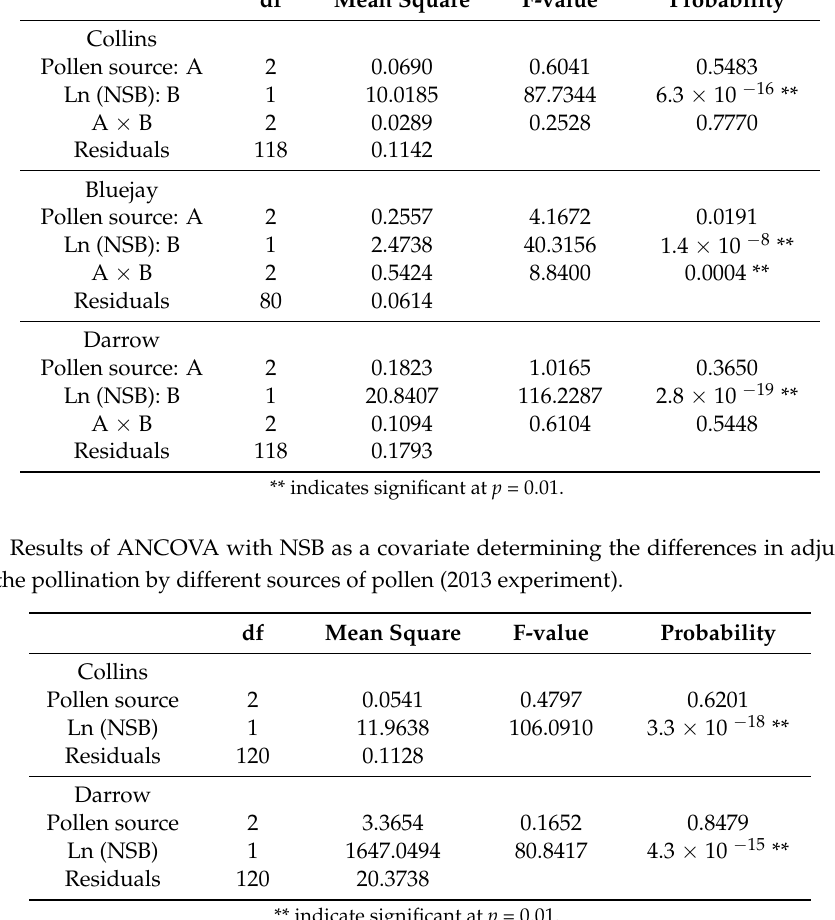
Table 2. Results of AVCOVA with NSB as a covariate determining the parallelism of the regression lines between NSB and BW in different pollen sources (2013 experiment). df Mean Square F-value